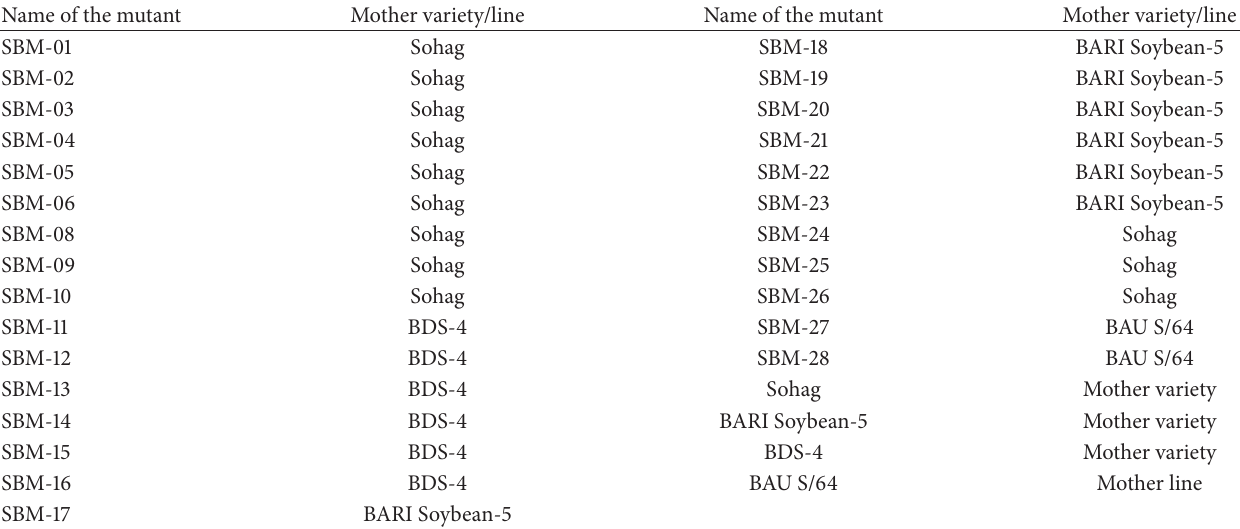
Table 1: List of 27 soybean mutants with their mother